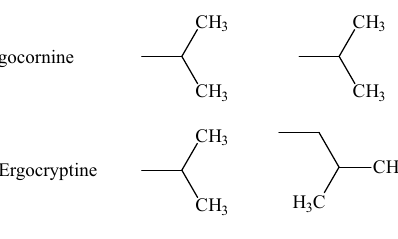
Figure 2. The left column shows the substitutions for R substitutions for R 2